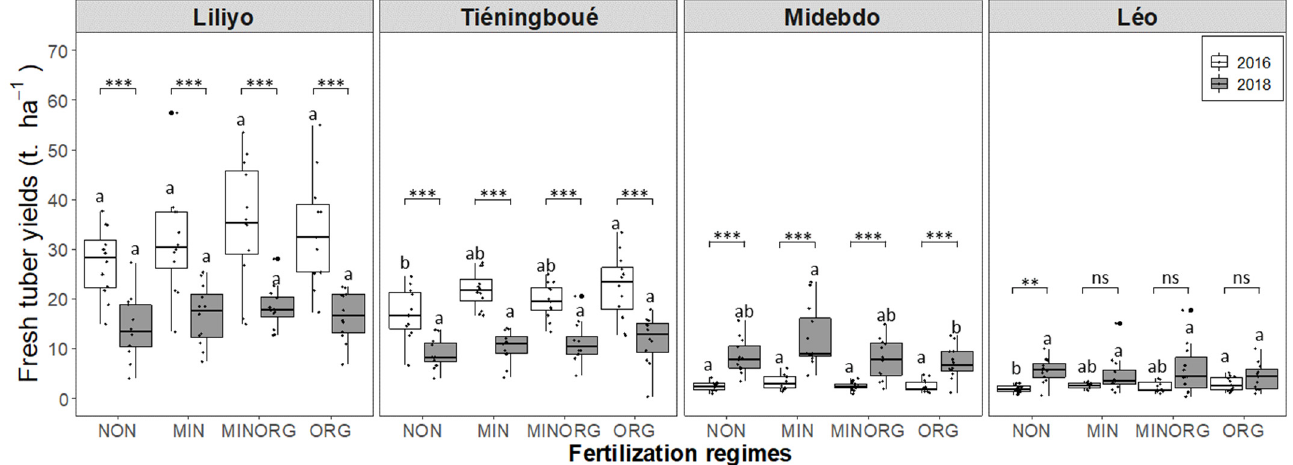
Figure 3. Effect of fertilization regimes and years on water yam fresh tuber yields in Liliyo and Tiéningboué (Côte d’Ivoire), and Midebdo and Léo (Burkina Faso), in 2016 and 2018. In 2016, the varieties cultivated were C18 for Liliyo, woroba for Tiéningboué, and florido for Midebdo and Léo. In 2018, yam variety C18 was cultivated in the four sites after either a cereal, a legume, or a yam for each fertilization regime. For each site and each year, different letters denote significant differences between fertilization regimes calculated by the Tukey test at p -level ≤ 0.05 ( n = 12 replicates per fertilization). Asterisks indicate the results of the t-test assessing the significance of the difference between the years for each site and fertilization regimes: ns, not significant, ** p <0.01, *** p <0.001. The fertilization regimes are: NON (no fertilization), MIN (sole mineral fertilization as NPK), MINORG combined organic and mineral fertilization), and ORG (sole organic fertilization as manure).